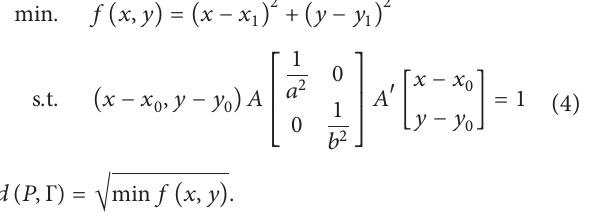
Figure 1: Flowchart of aggregate and fiber